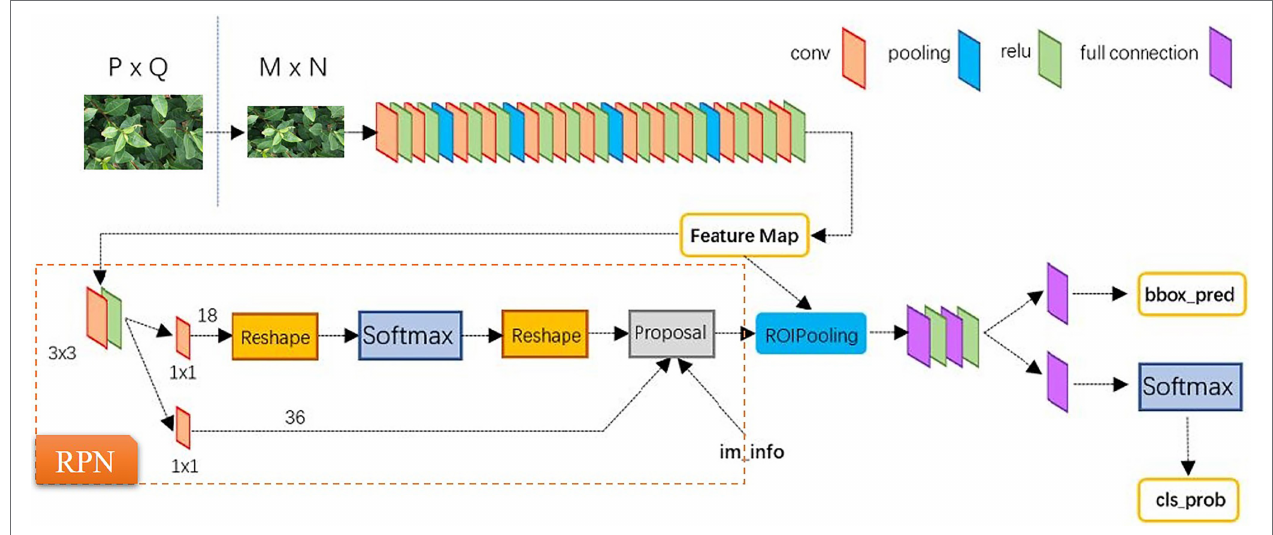
FIGURE 4 | The structure of Faster